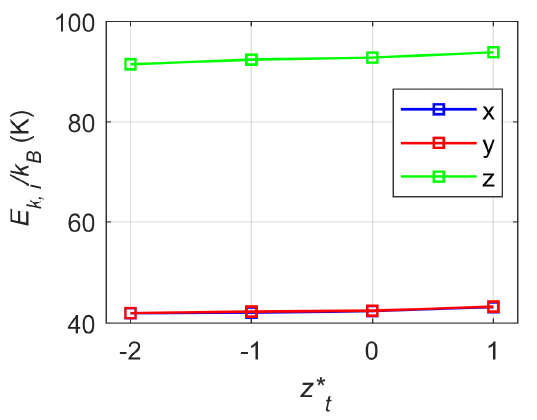
Figure 10. The average kinetic energy components in x , y , and z axis of evaporating argon atoms as a functions of normalized thermostat boundary position at the right-side